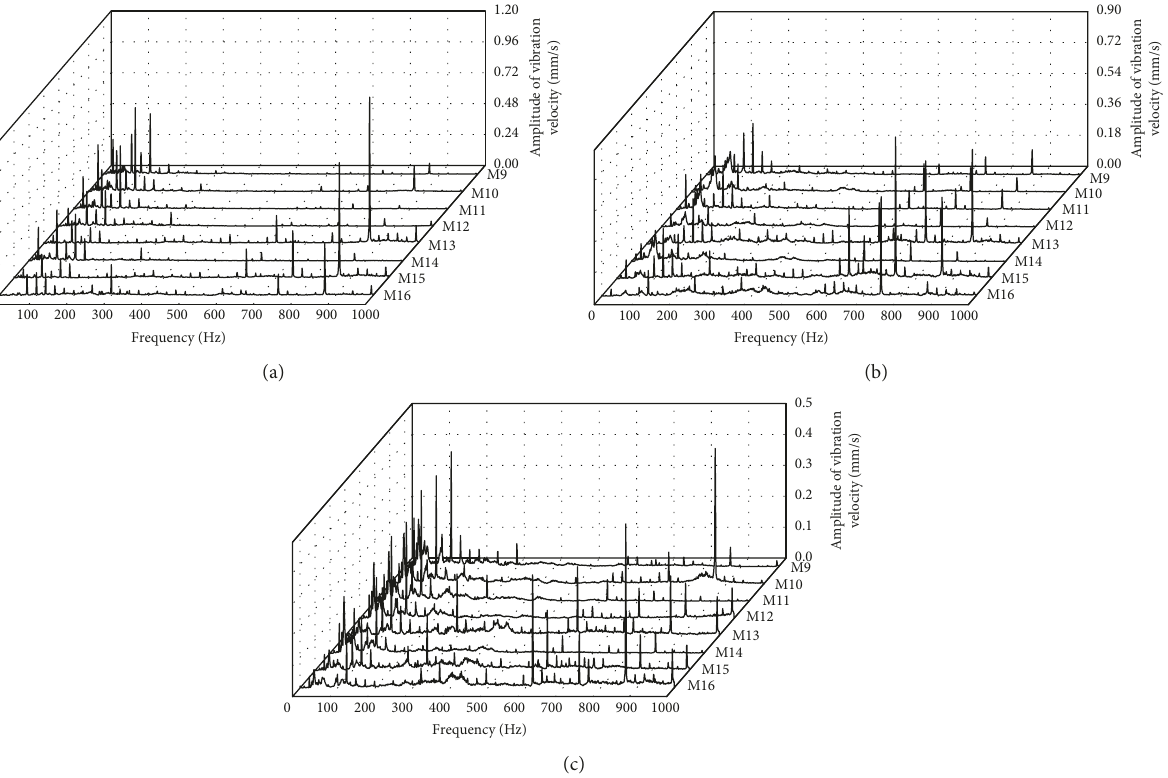
Figure 9: Frequency domain of vibration at M9 ∼ M16 in the (a) X direction, (b) Y direction, and (c) Z